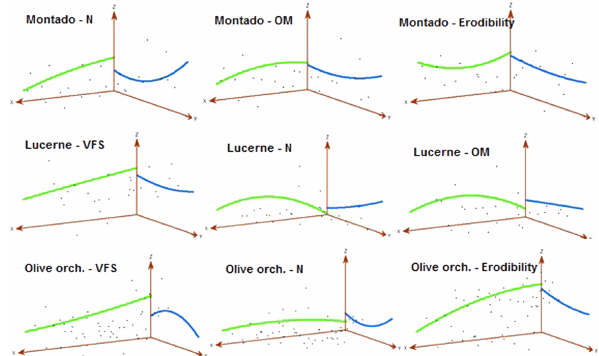
Figure 2. Three-dimensional perspective of the trends in the input data